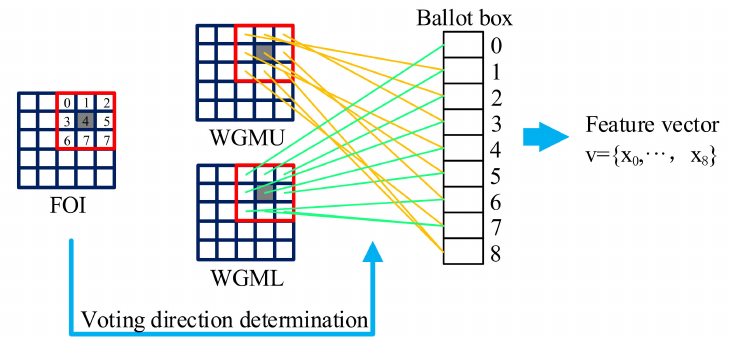
Figure 4. The statistical process of a feature vector with 9 elements. WGML and WGMU refer to the two weighted gradient magnitude images.